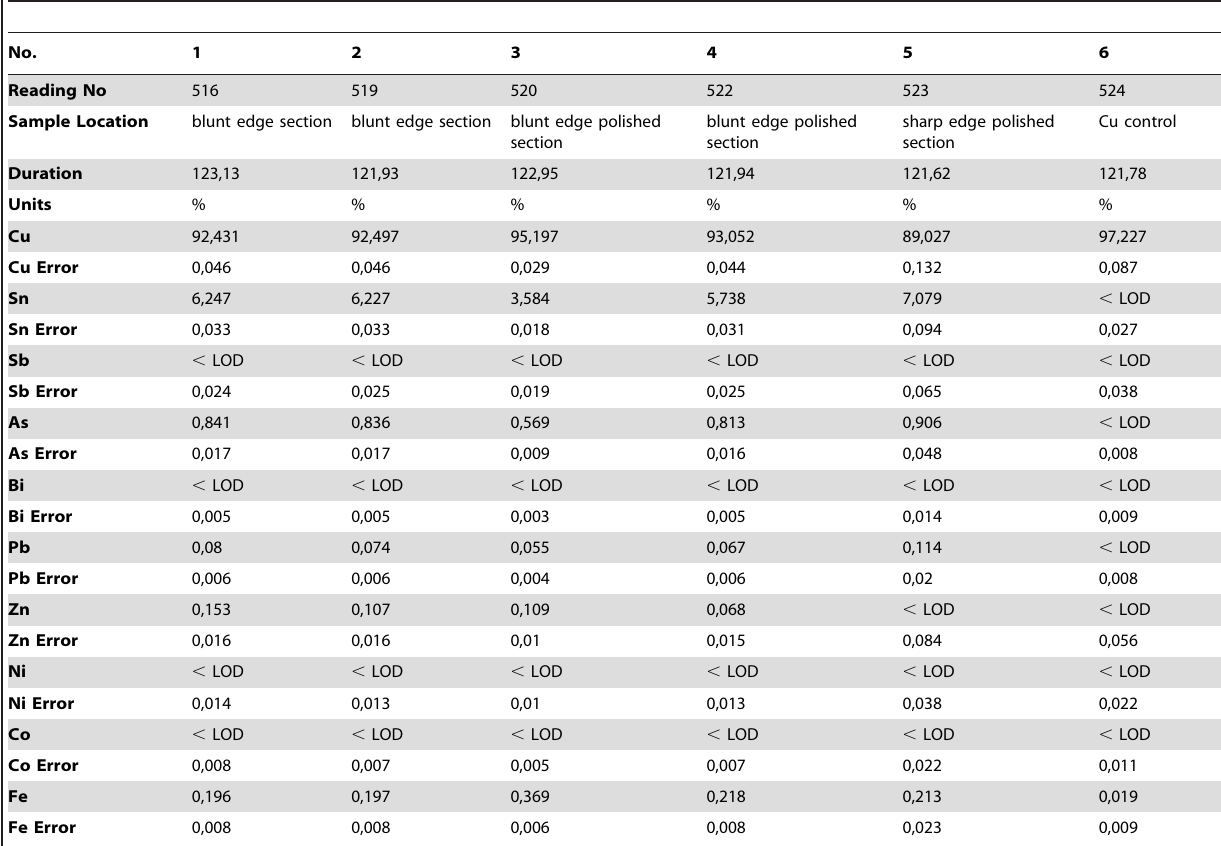
Table 1. Results of portable Niton ED-XRF analysis (beam size: 3 mm in diameter).